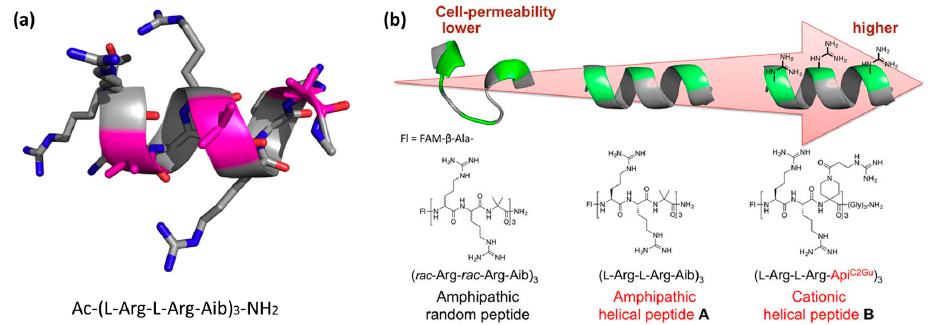
Figure 6. ( a ) Calculated minimum energy conformation of a short Aib-containing CPP, where helix stabilization is induced at primary structure level, reproduced with permission from reference [129] (Copyright © 2014 Elsevier); ( b ) Schematic representation of the relationship of secondary structure properties of CPPs and their cell permeability in various environments, taken from reference